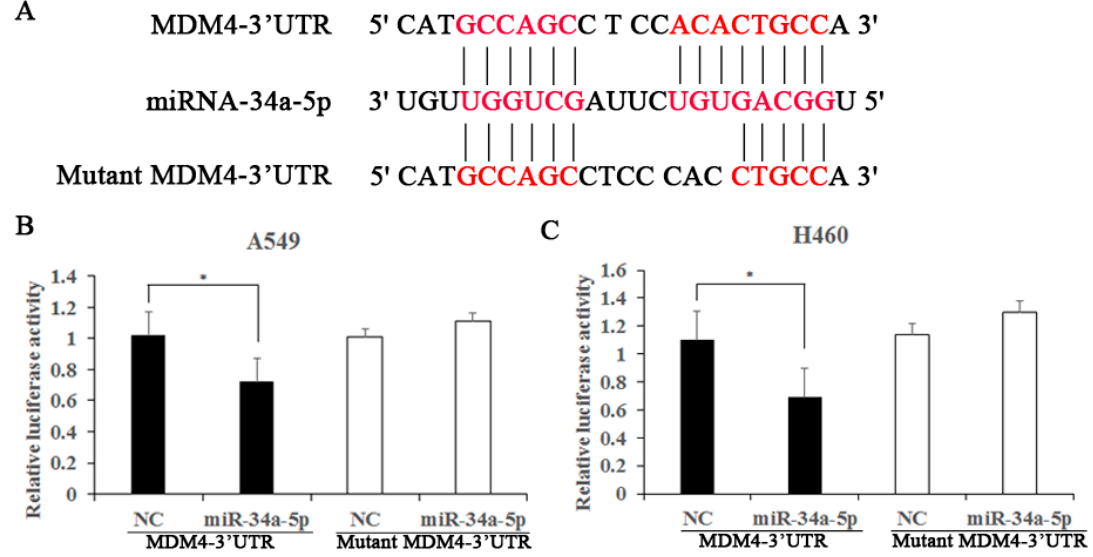
Figure 6. MDM4 is a direct target of miR-34a-5p in A549 and H460 cells. ( A ) The sequence of miR- 34a-5p and its binding sites in the 3 ′ -UTR of MDM4 mRNA; The red letters stand for complementary base pairing between miRNA-34a-5p and 3 ′ -UTR of MDM4 mRNA; ( B , C ) Luciferase activity was measured in A549 and H460 cells with a dual-luciferase reporter assay. The MDM4-3 ′ -UTR or the mutant MDM4-3 ′ -UTR vectors and the miR-34a-5p mimics or negative controls were co-transfected into cells with Lipofectamine 2000. The relative luciferase activity was normalized to the Renilla luciferase activity. The results are expressed as means ± SD of three independent experiments. * p < 0.05, compared with the